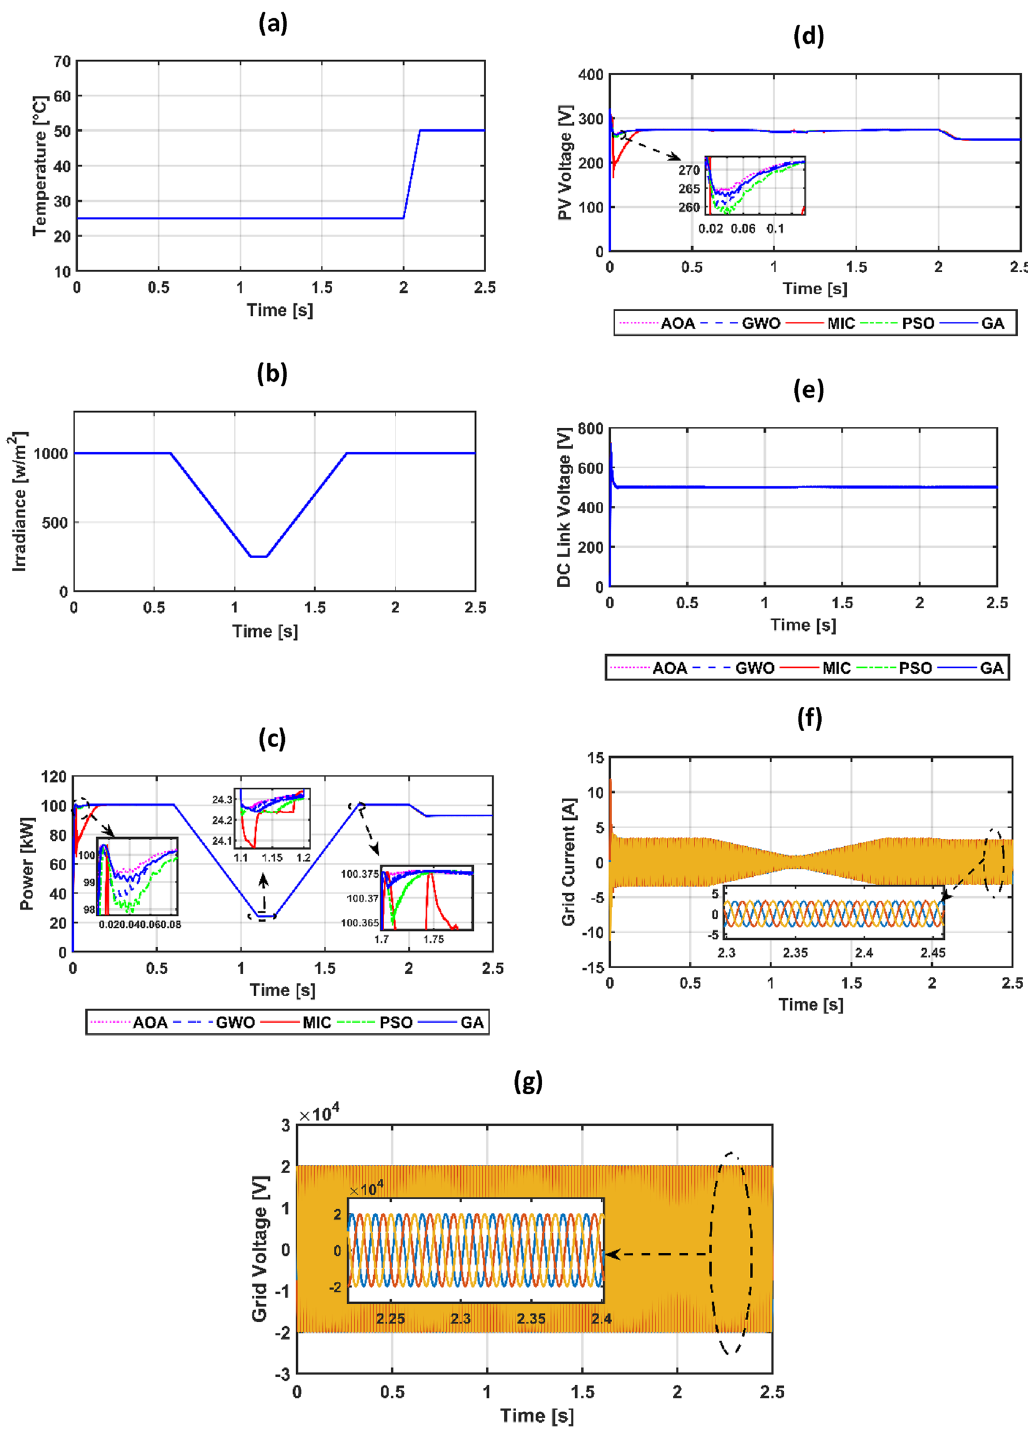
Figure 10. ( a ) ramp temperature, ( b ) ramp irradiance, ( c ) PV power, ( d ) PV voltage, ( e ) voltage of DC link, ( f ) utility current-based AOA, ( g ) utility voltage-based 79.3% over MIC, GWO, GA, and PSO in extracting the maximum output of the PV system. Besides, in the second scenario, the dynamic response of AOA outperformed that of GWO, GA, and PSO but MIC is the worst performance even in steady-state or transient response. In the third scenario, all techniques succeed in tracking the MPP. In the fourth scenario, AOA PV voltage is the fastest, followed by GA, GWO, PSO, and MIC, whereas MIC takes the longest to track the voltage. In the last case study, the PV power obtained by AOA is the fastest